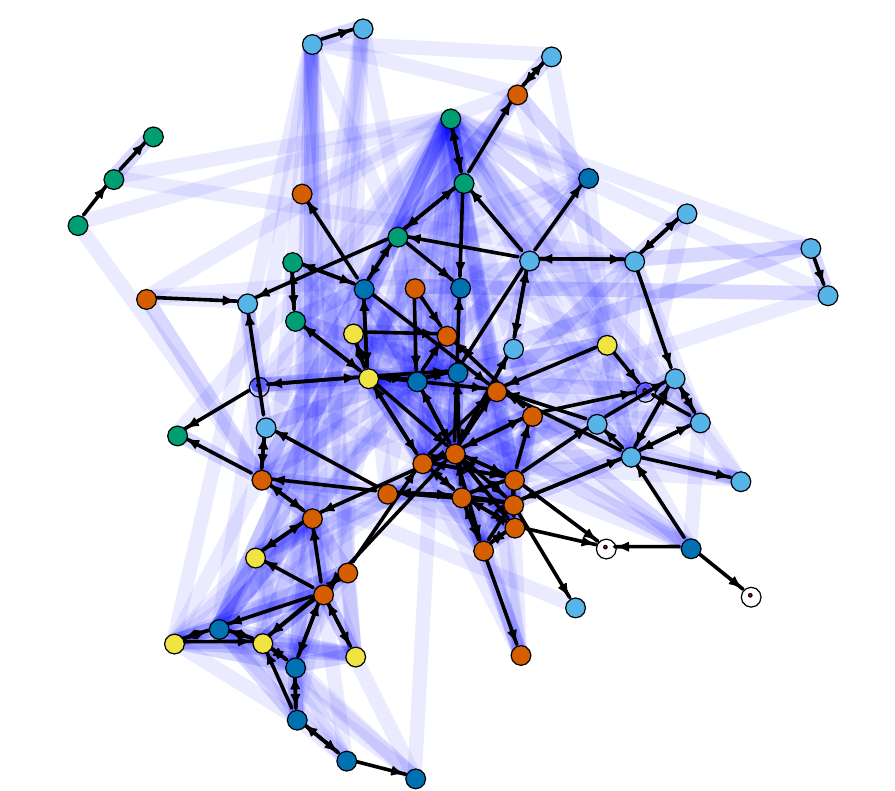
Figure 4: The call network (without isolates) of the first two months of data collection. Friendship relations are indicated by shadowed ties in the background. The node color relates to the grade type of individuals; missing values are indicated by nodes with a central